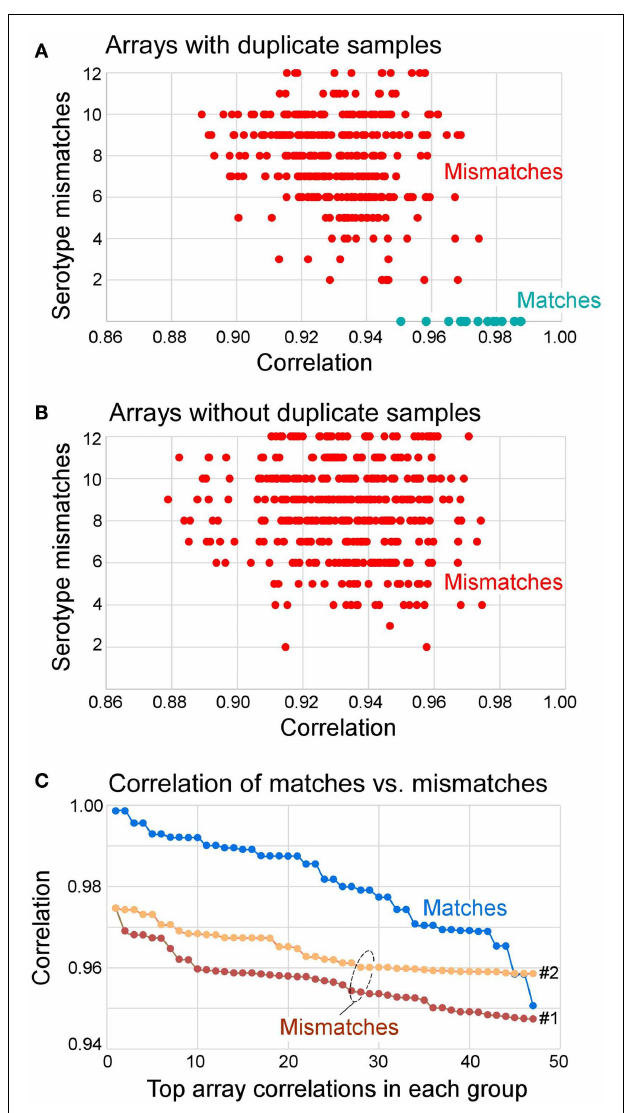
FIGURE 3 | Distribution of correlation coefficients between matched and mismatched pairs and the number of serotype mismatches . (A) Arrays that had duplicate samples in the knowledgebase (also see Table 5 ) paired with all other samples.The results show that all matches had zero serotype mismatches. All mismatches had 2–12 serotype mismatches. (B) Arrays that did not have duplicate samples in the knowledgebase of templates all had 2–12 serotype mismatches. (C) Distribution of top 47 correlation coefficients segregated by matches, mismatches to repeat samples (Mismatches 1, of 360 total), and mismatches of all other samples (Mismatches 2, of 527 total).The Mismatches 1 correspond to data shown in ( A) and Mismatches 2 correspond to data shown in (B) . In summary, 70% of matches can be determined from correlation coefficient